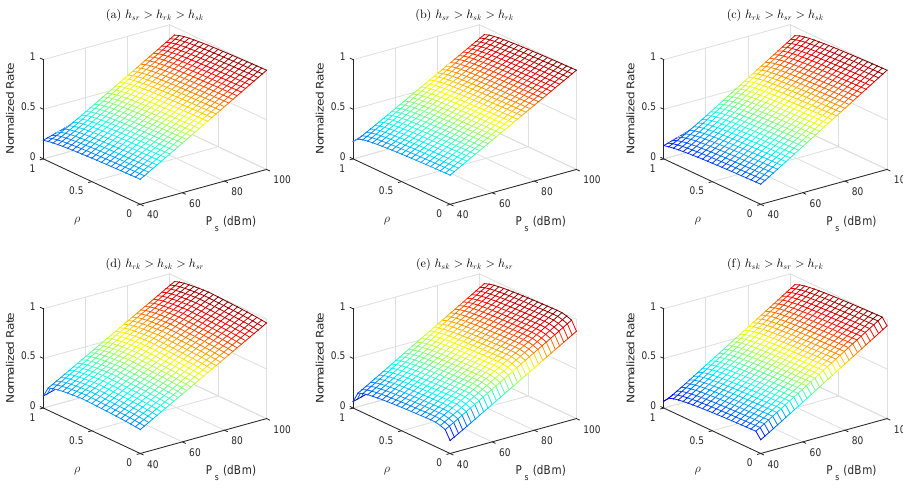
Figure 2. Objective function for different channel